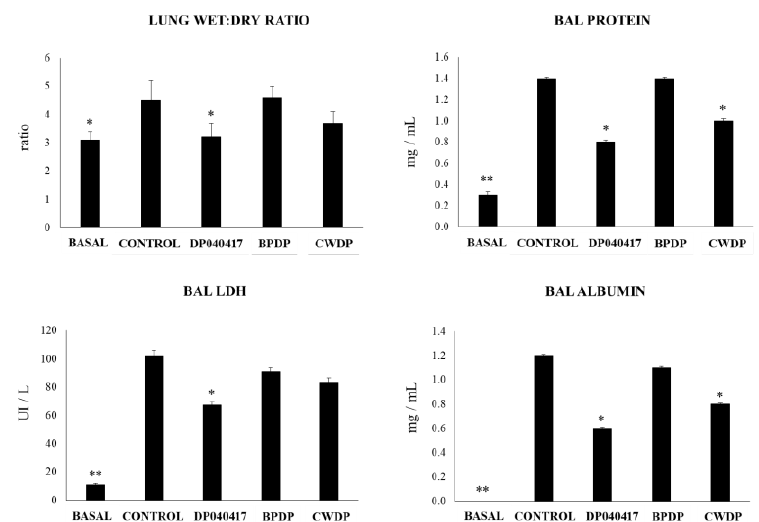
Figure 7. Effect of Dolosigranulum pigrum 040417 on lung tissue damage induced by the nasal administration of the viral pathogen-associated molecular pattern poly(I:C). Infant mice were nasally primed with viable (DP), bacterium-like particles (BPDP) or cell wall (CWDP) from D. pigrum 040417 during five consecutive days and then challenged with three once-daily doses of poly(I:C). Non-treated infant mice challenged with poly(I:C) were used as controls. Two days after the last poly(I:C) administration lung wet:dry weight ratio, lactate dehydrogenase (LDH) activity and, albumin and protein concentrations in broncho-alveolar lavages (BAL) were determined. Experiments were performed with 5–6 mice per group. The results represent data from three independent experiments. Significantly different when compared to control * p < 0.05 or ** p < 0.01.